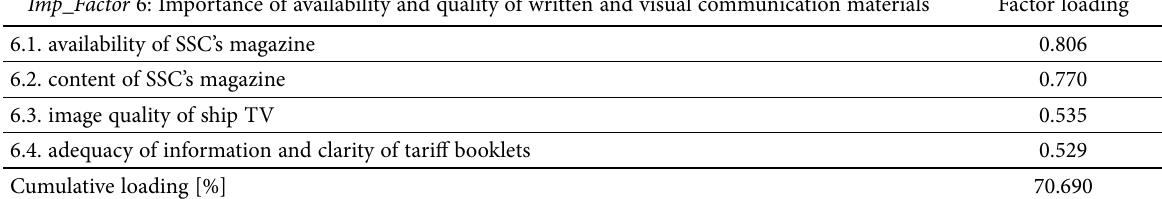
Table 16. Importance Factor 6 factor